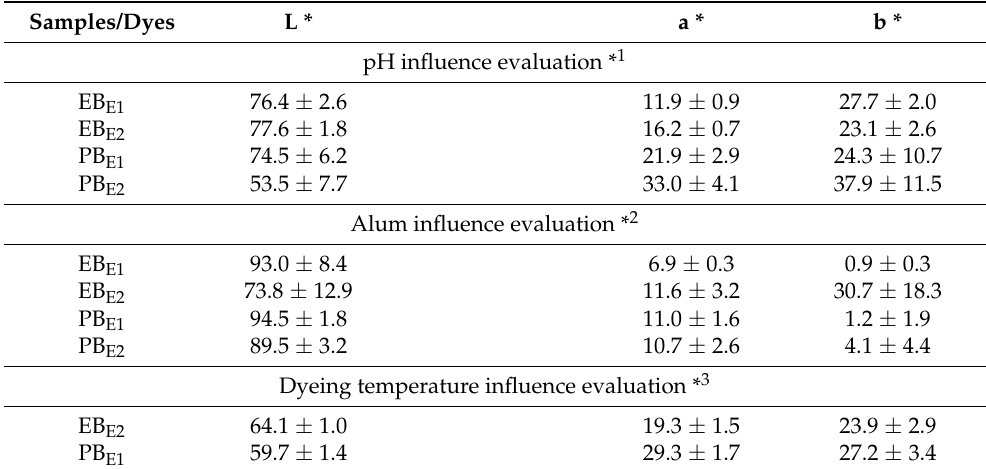
Table 4. Evaluation of the dyeing conditions: influences of pH, mordant and dyeing temperature.